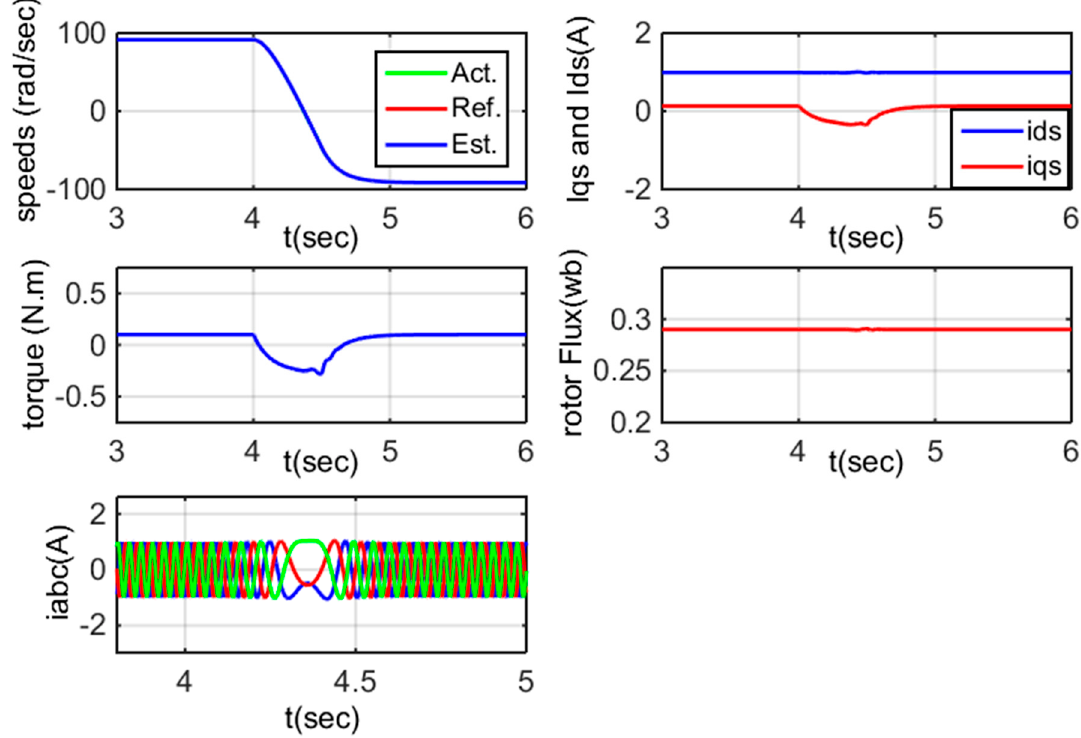
Figure 12. System performance when reversing the motor speed.